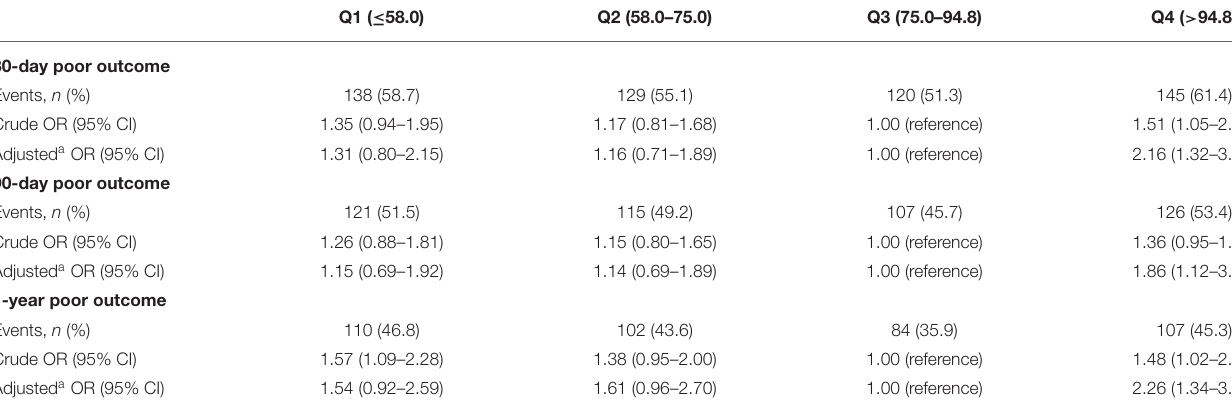
TABLE 2 | Crude and adjusted OR of ALP levels for 30-day, 90-day, and 1-year poor outcomes.